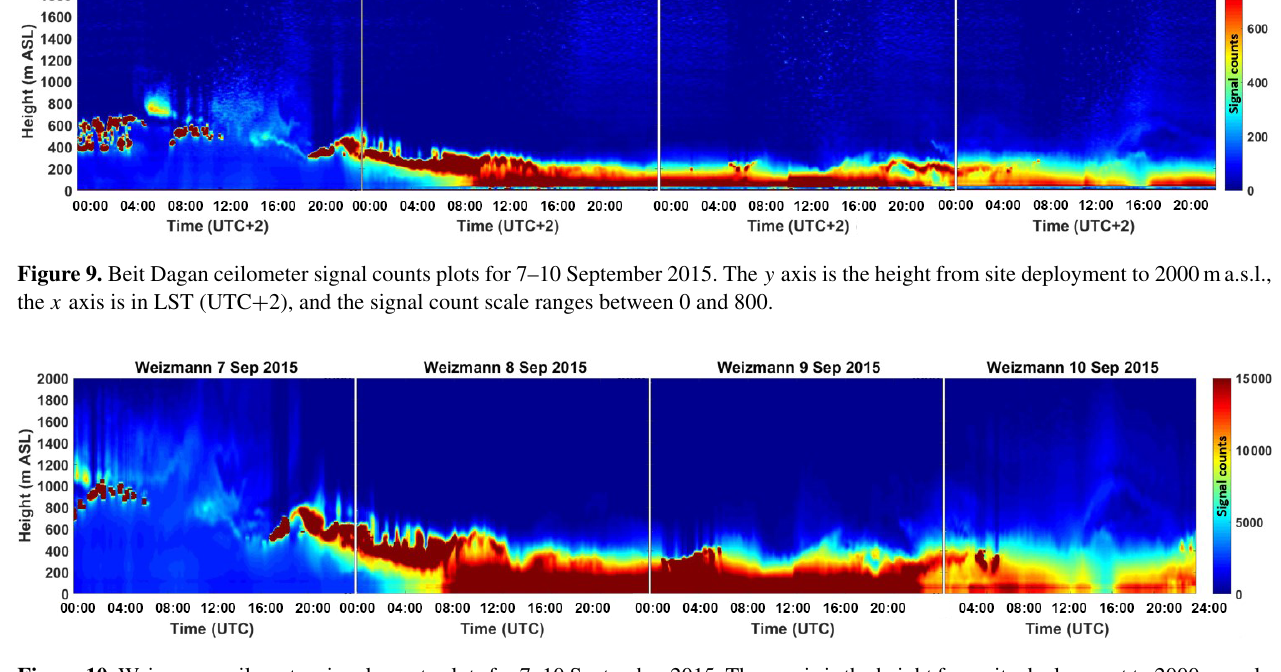
Figure 10. Weizmann ceilometer signal counts plots for 7–10 September 2015. The y axis is the height from site deployment to 2000ma.s.l., the x axis is in UTC, and the signal count scale ranges between 0 and 15000.